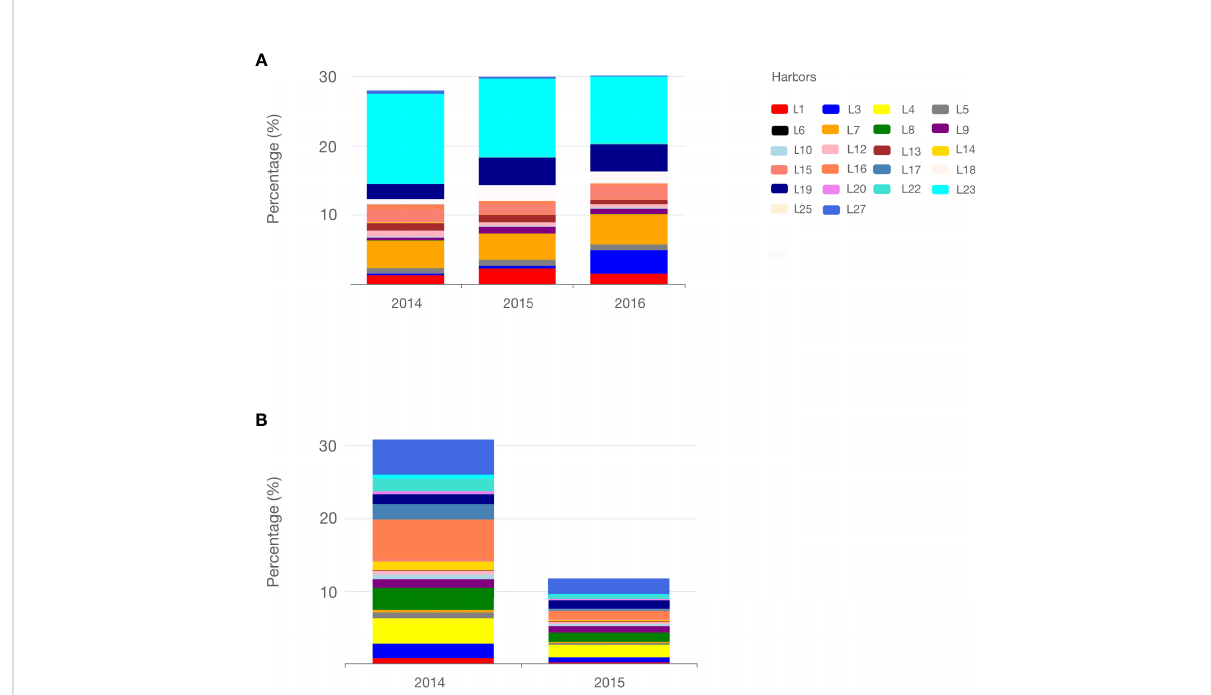
FIGURE 5 Percentage of suspect data for each harbor relative to each year for non-motorized (A) and motorized (B) canoes. No suspect data were found from the harbors L2, L11, L21, L24, and L26; hence, these sites are not shown in the